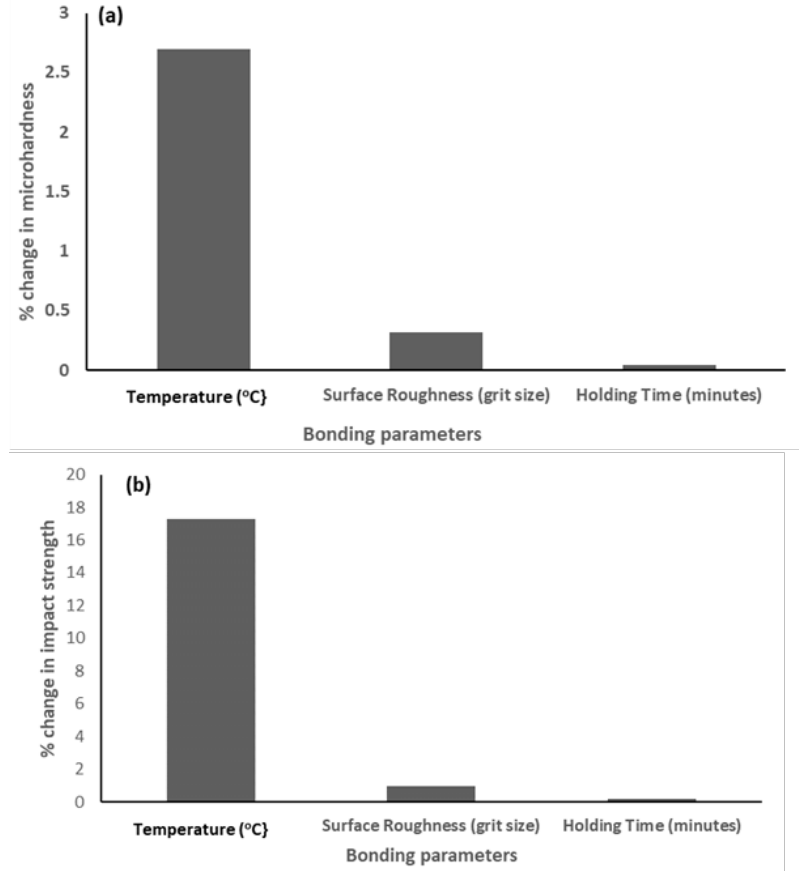
Figure 18. Sensitivity of the joint’s mechanical properties to 1 % change in bonding parameters: ( a ) Microhardness; ( b ) Impact strength.